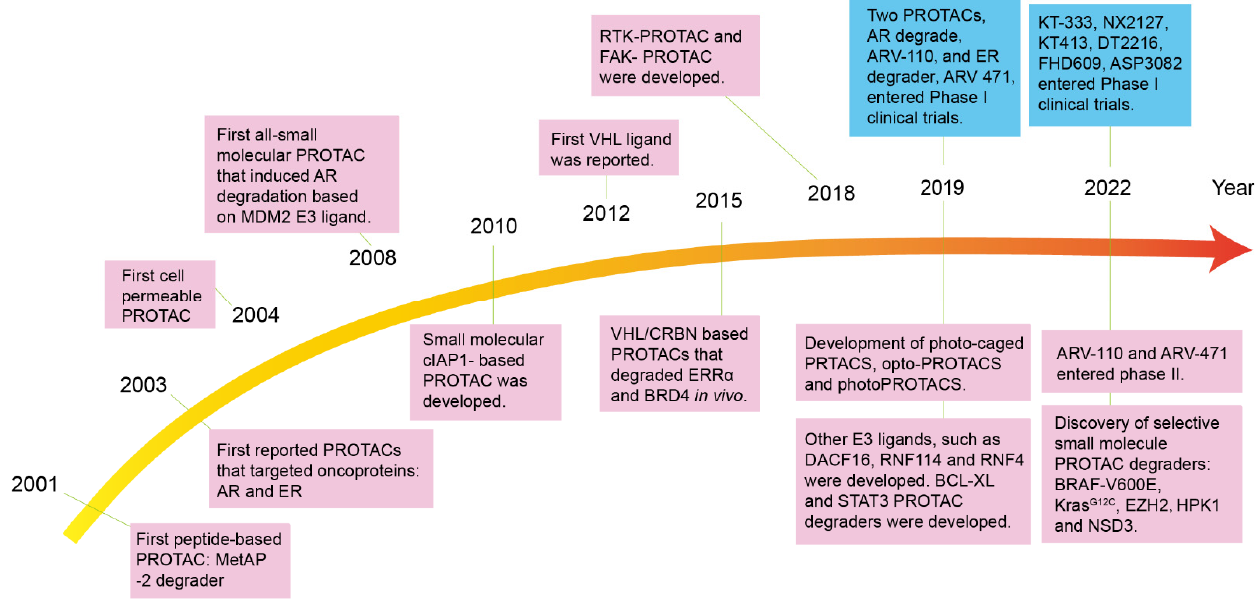
Figure 2. Timeline of PROTACs technology [9,12,15,25]. The concept of PROTAC was first proposed in 2001 when Sakamoto et al. [8]. developed the first peptide-based PROTAC. Since then, PROTAC technology has flourished, from peptide-based to small molecule-based PROTACs which adopt dif- ferent types of E3 ligases to the later improved small-molecule PROTACs such as photoPROTAC [93]. In 2019, the results of Phase I clinical trials of ARV-110 [3], an AR inhibitor, and ARV-471 [4], an ER inhibitor, confirmed the feasibility and efficacy of PROTACs in degrading pathogenic proteins to treat human diseases. An increasing number of PROTACs are now designed to target different disease-causing proteins, and they have begun to enter the clinic, which hopefully will provide meaningful benefits to cancer patients